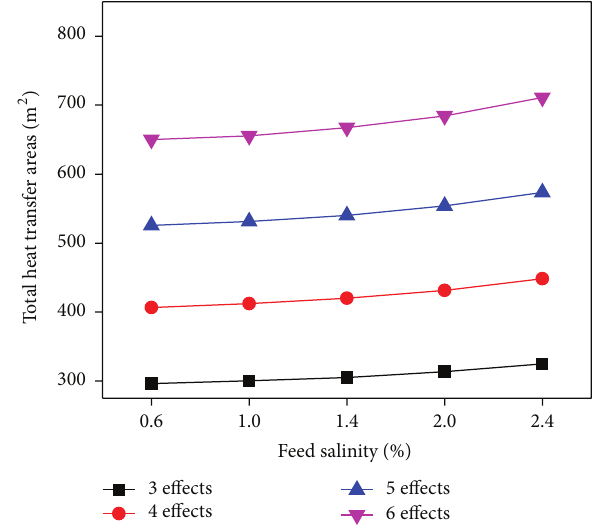
Figure 5: Variation of steam consumption with feed salinity.